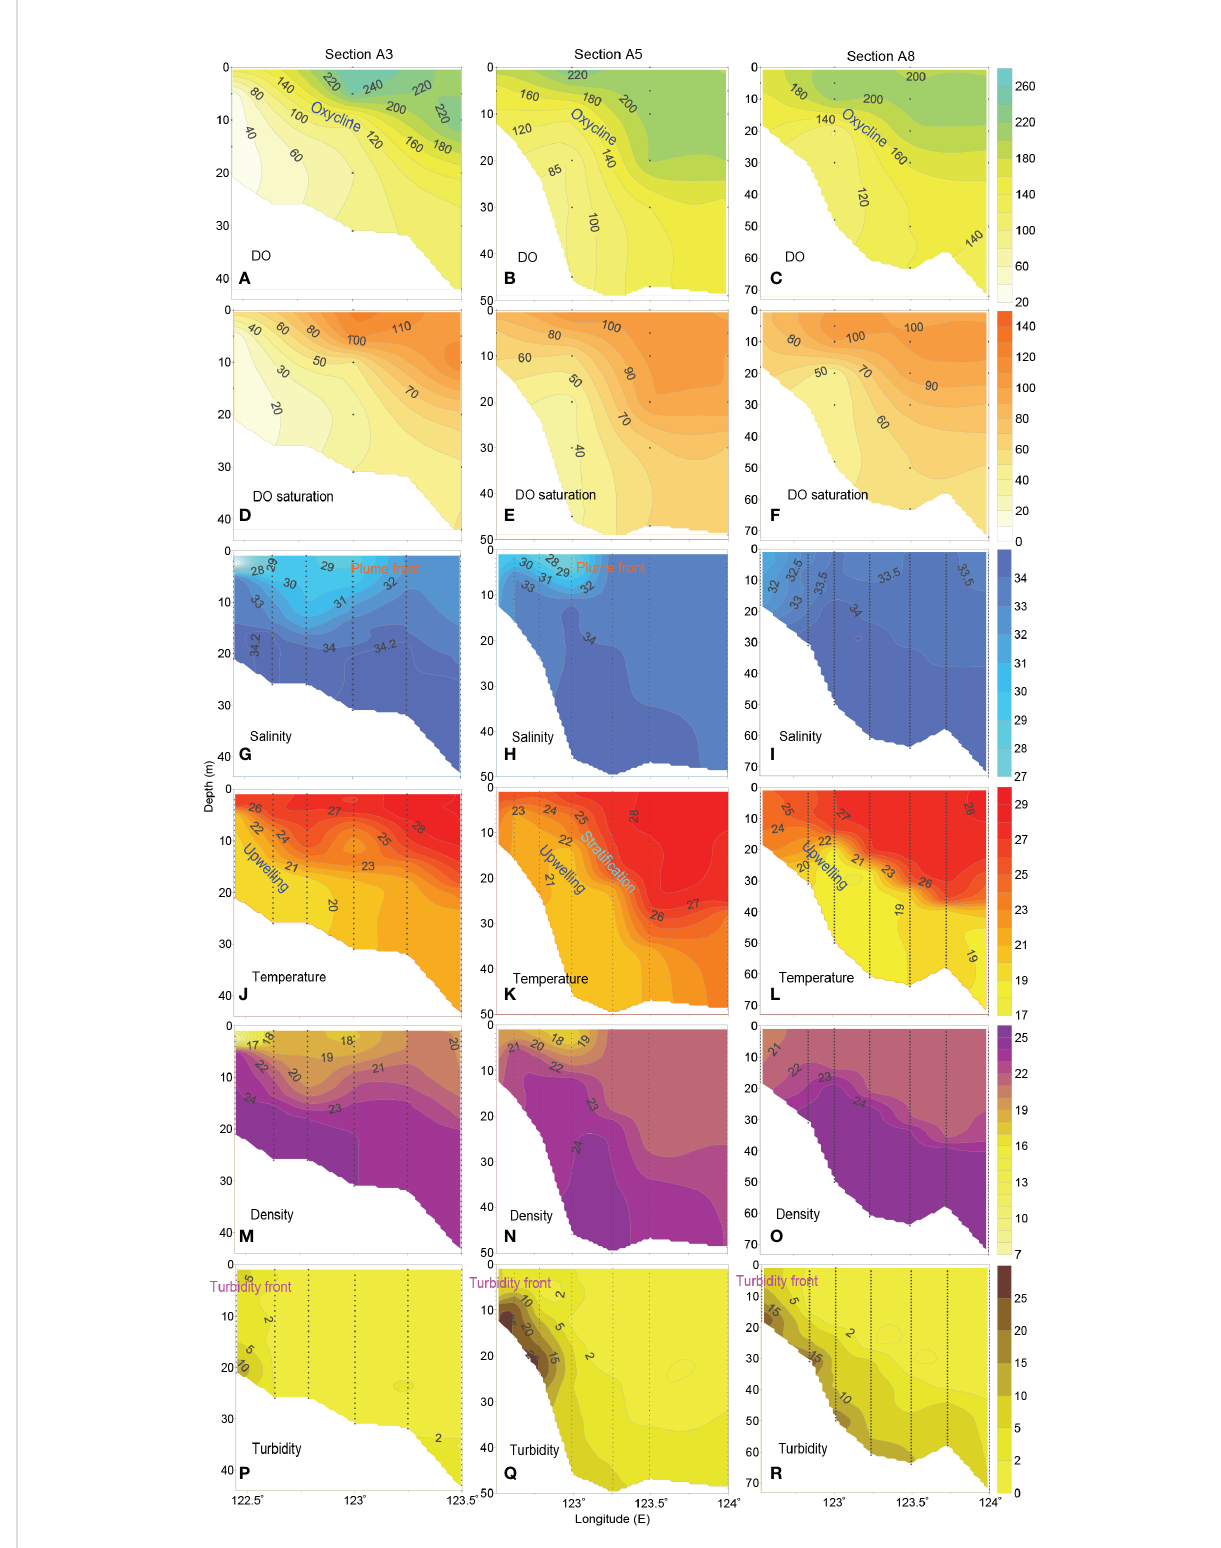
FIGURE 3 Vertical distributions of (A – C) DO ( m mol dm -3 ), (D – F) DO saturation (%), (G – I) salinity, (J – L) temperature (°C), (M – O) potential density (kg m -3 ) and (P – R) turbidity (NTU) along typical sections off the CE in August